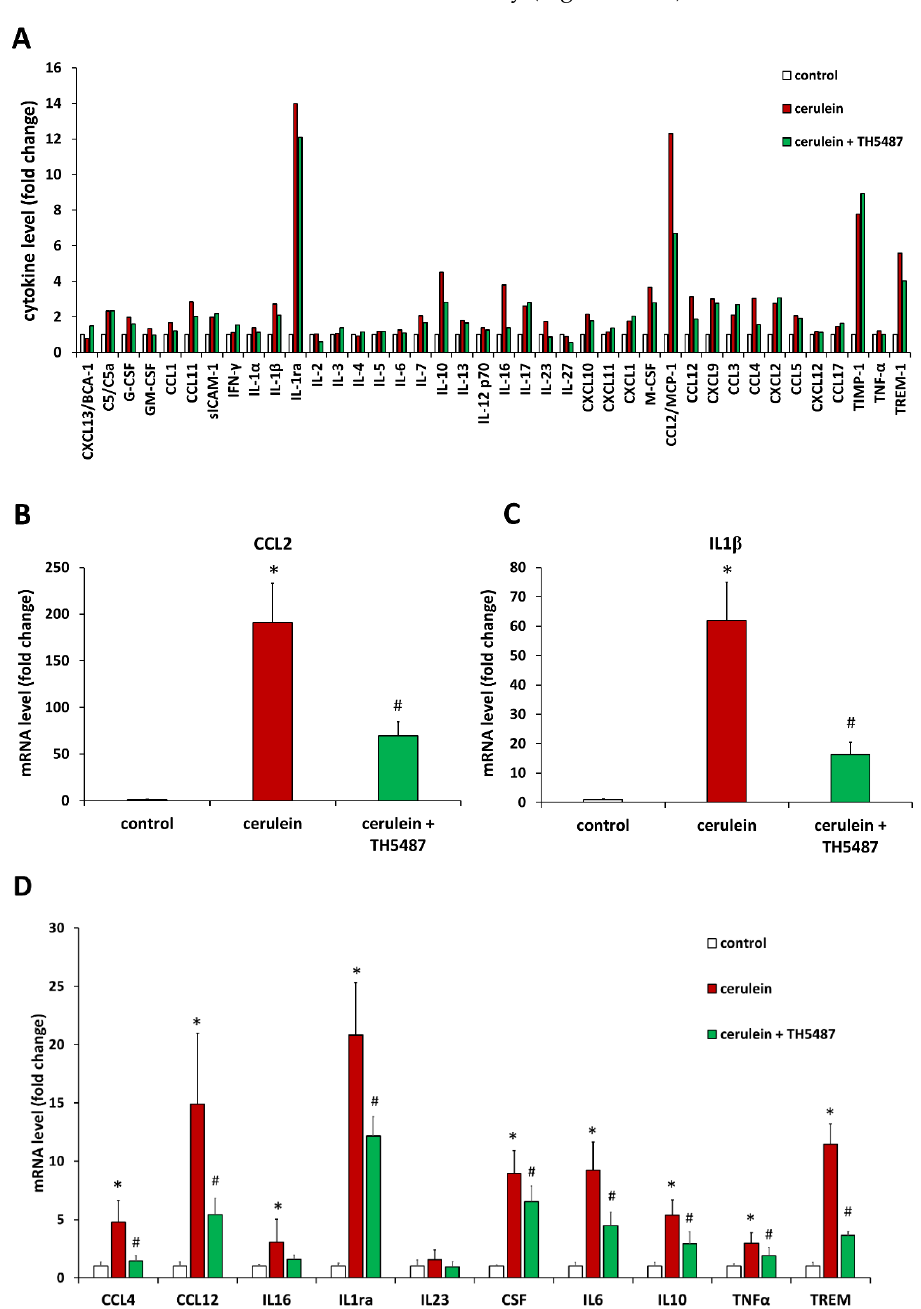
Figure 6. TH5487 prevents proinflammatory cytokine production in AP. Cytokine levels were measured with cytokine arrays from pancreas tissues obtained 10 h after the first cerulein injection. TH5487 markedly reduced the level of CCL2 ( A ). The relative expressions of cytokines and chemokines in pancreata were measured by qPCR. Cerulein caused a 190-fold increase in CCL2 mRNA level ( B ) and a 61-fold increase in IL1 β mRNA level ( C ). The OGG1 inhibitor significantly suppressed both CCL2 and IL1 expressions ( B , C ). TH5487 also significantly reduced the expression of several other proinflammatory genes ( D ). qPCR data are presented as mean ± SD, n = 6. * p < 0.05 vs. control group, # p < 0.05 vs. cerulein group.